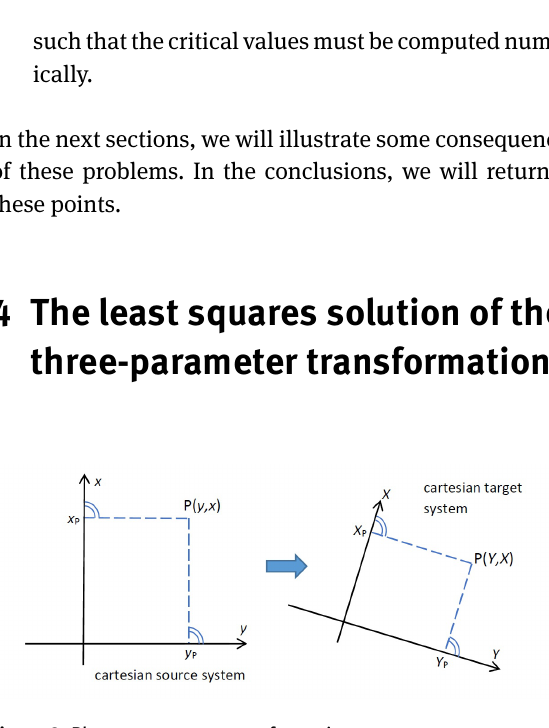
InaplaneconsidertwoCartesianreferenceframes x , y and X , Y , which are related by translation and rotation, such that an arbitrary point P has coordinates x satisfying the non-linear transformation equations